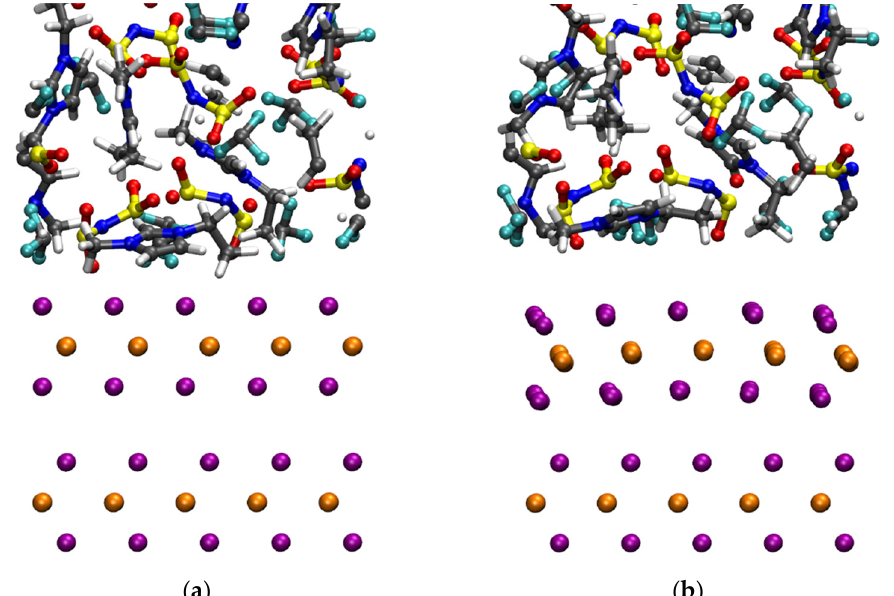
Figure 9. Snapshots of configurations of the ionic liquid [EMIM] [TFSI] obtained at T = 300 K by using the vdW scheme D2 (or MLWF, panel ( a )) and D3 (panel ( b )) within the same FPMD framework. In the figures, the orange and purple spheres in the bottom layers represent the W and the Se atoms, respectively. For the ionic liquid, the atom color code is gray for C, blue for N, red for O, yellow for S, cyan for F, and white for H.